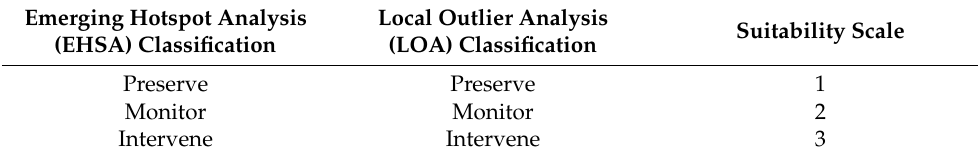
Table 10. Common suitability scale used to transform EHSA and LOA Classification maps. Emerging Hotspot Analysis